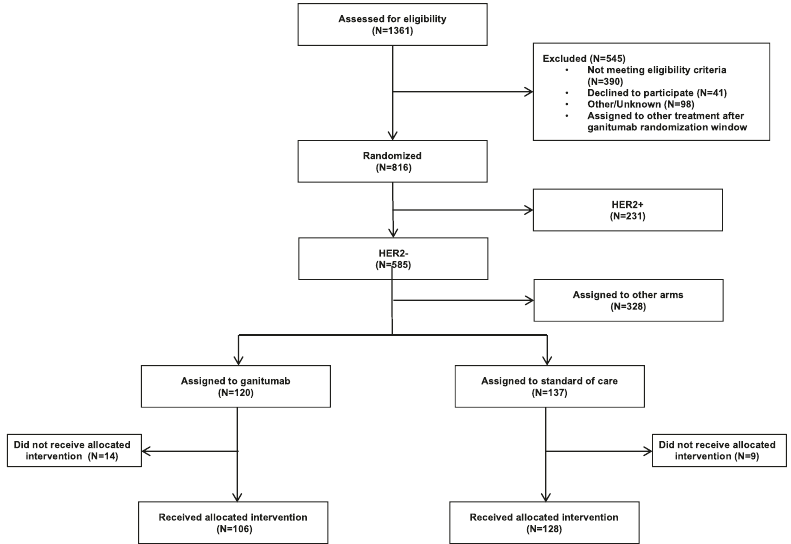
Fig. 1 CONSORT diagram for paclitaxel, ganitumab, metformin arm in I-SPY2.